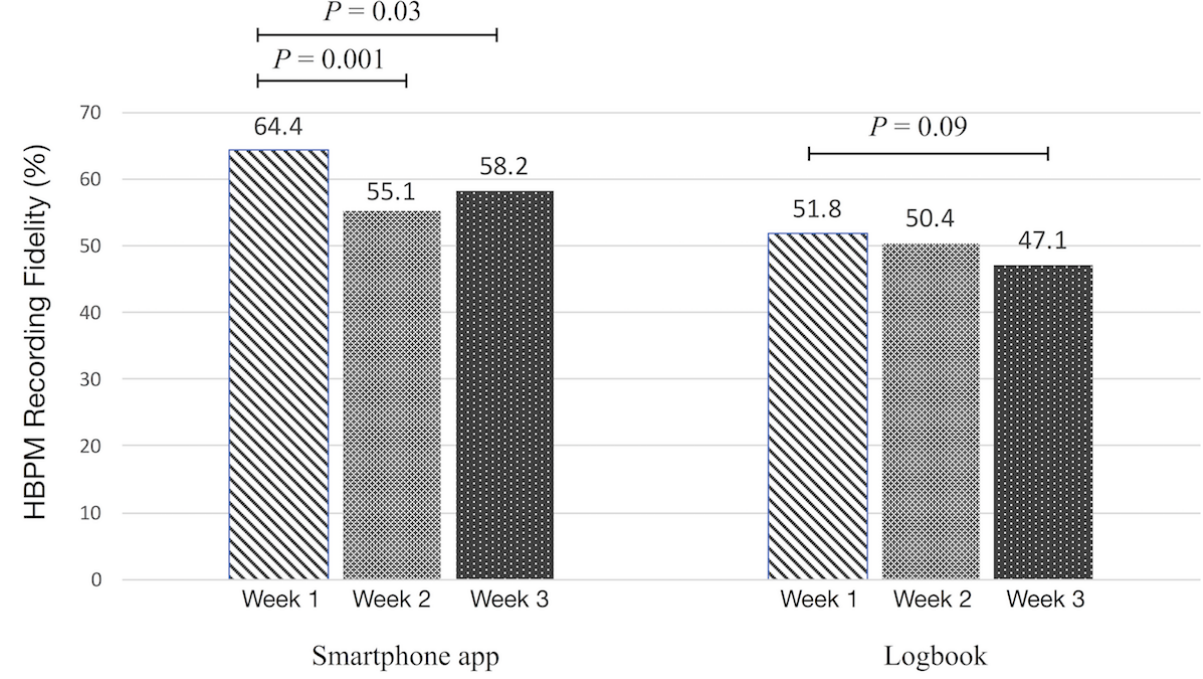
Table 3. Comparison of home blood pressure recording fidelity by study weeks.